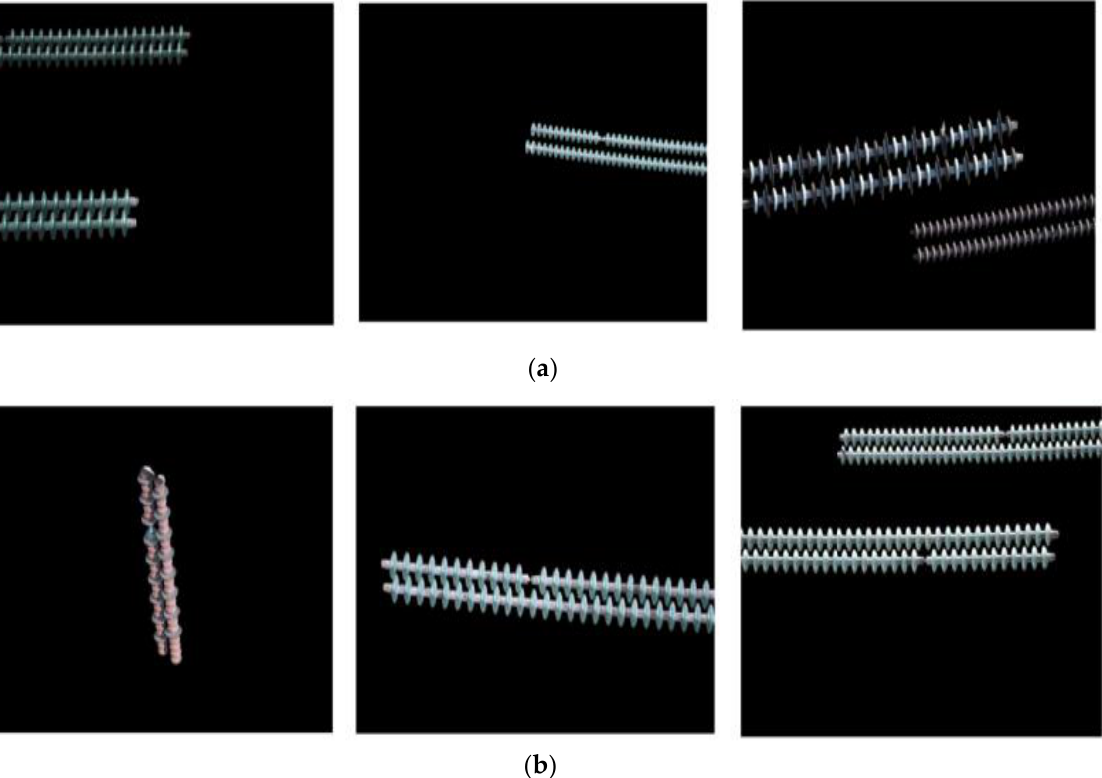
Figure 19. Mask examples mapped to the raw image after filtering under different backbones. ( a ) MobileNetV2. ( b ) ResNet.